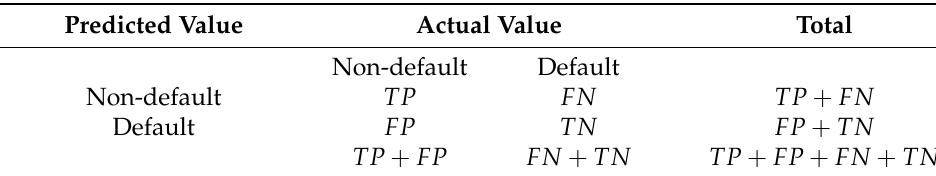
Table 6. Confusion